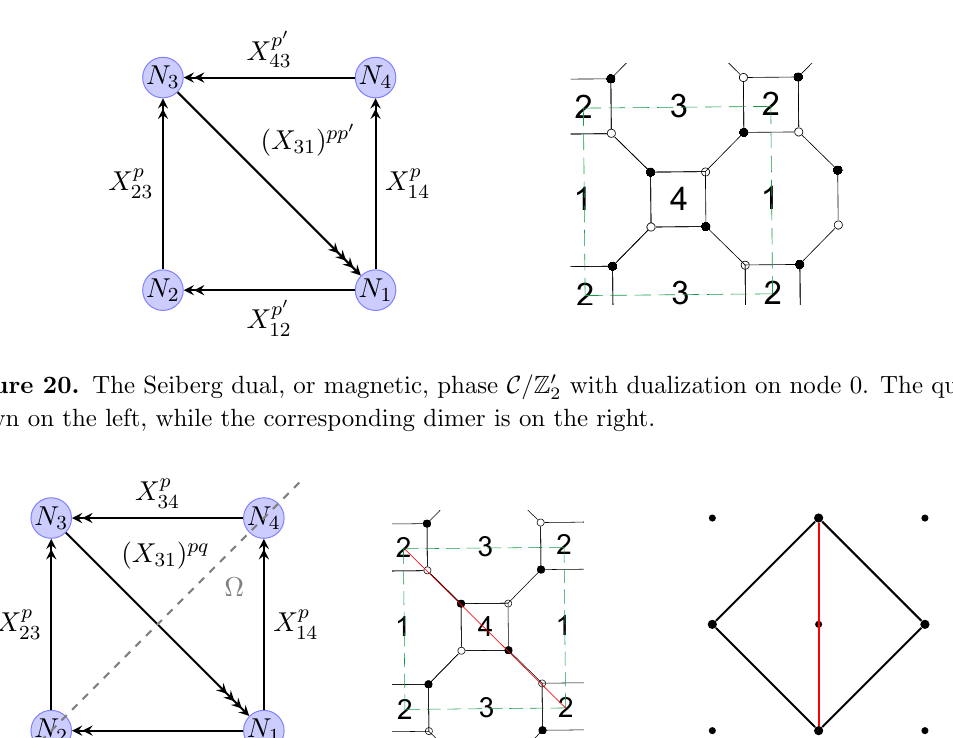
, whose quiver is drawn on the left 2